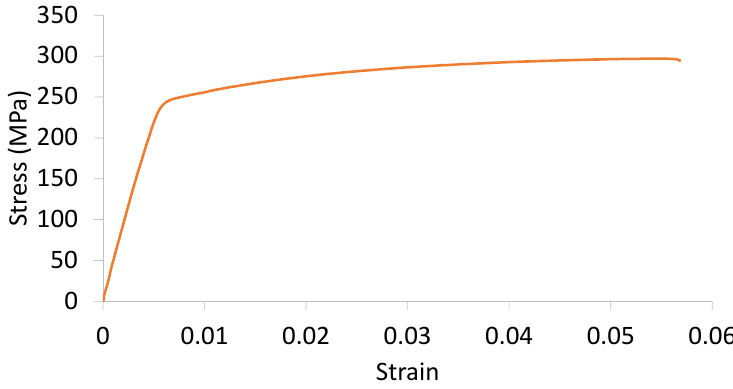
Figure 5. Elasto-plastic profile of the AZ31B alloy used in FE modelling.